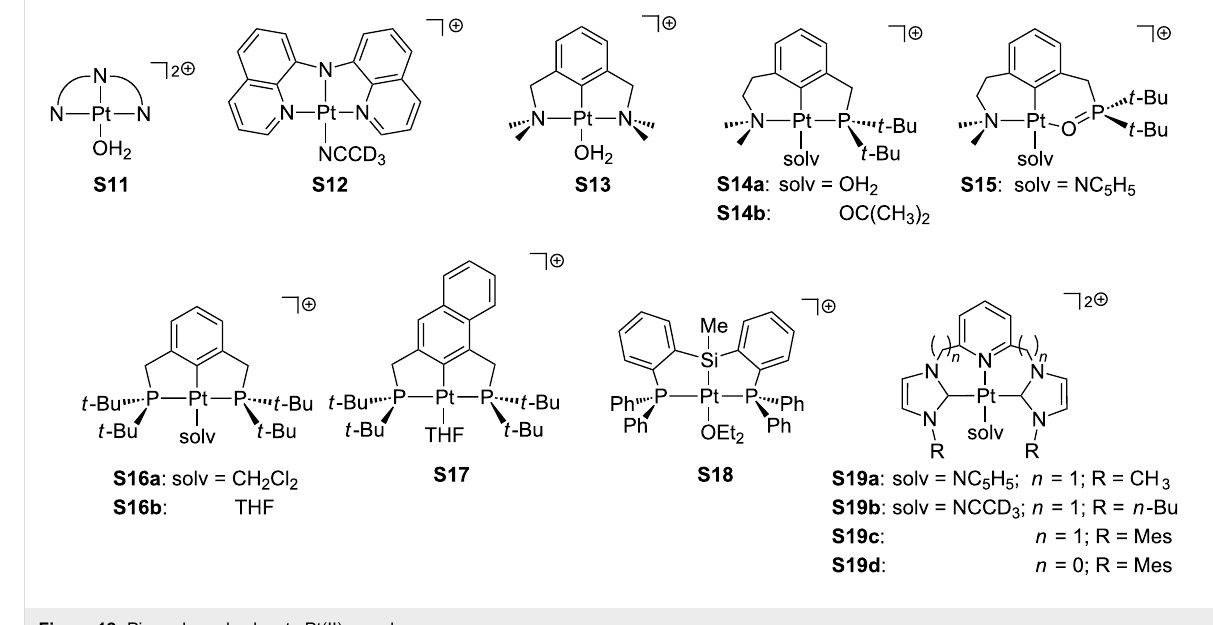
Figure 12: Pincer-based solvento Pt(II)